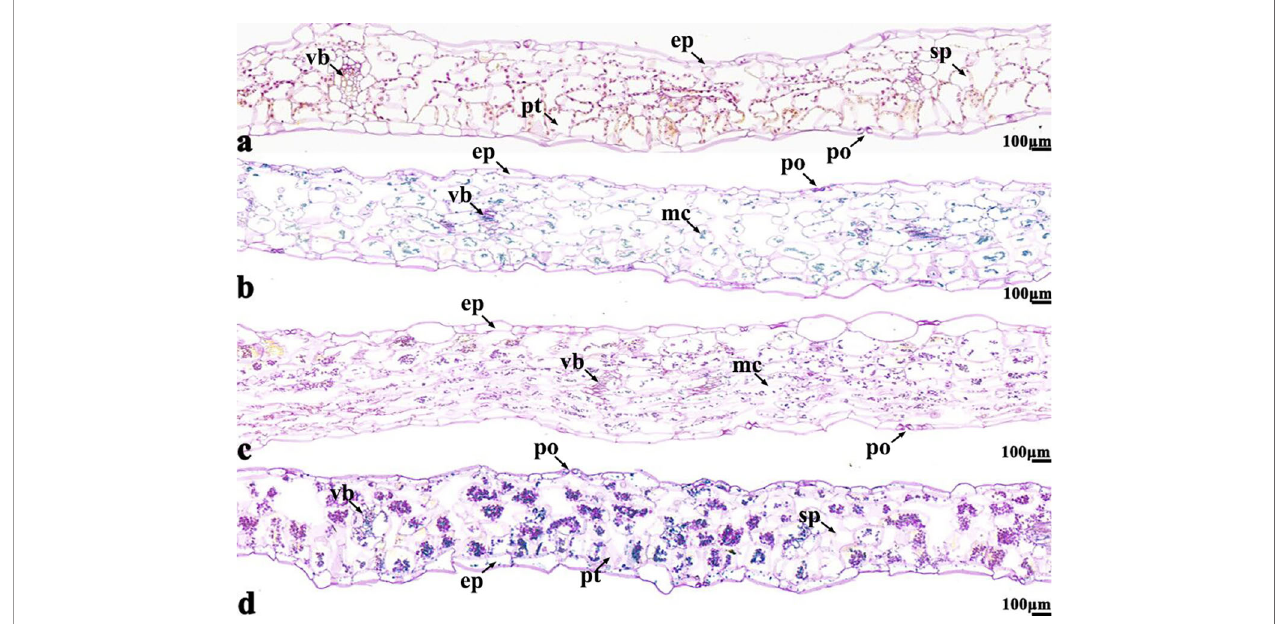
FIGURE 7 | B. napus cultivars 16NTS309 and Tianyou2238 under non-cold (A, C) and cold stress (B, D) conditions for 48 h. The deepest leaf samples with blue formazan precipitate areas in 16NTS309 (A, B) and Tianyou2238 (C, D) were sectioned for morphoanatomical analysis. po, pore; ep, epidermis; sp, spongy parenchyma; pt, palisade tissue; vb, vascular bundle; ep, epidermis. Scale bars = 100